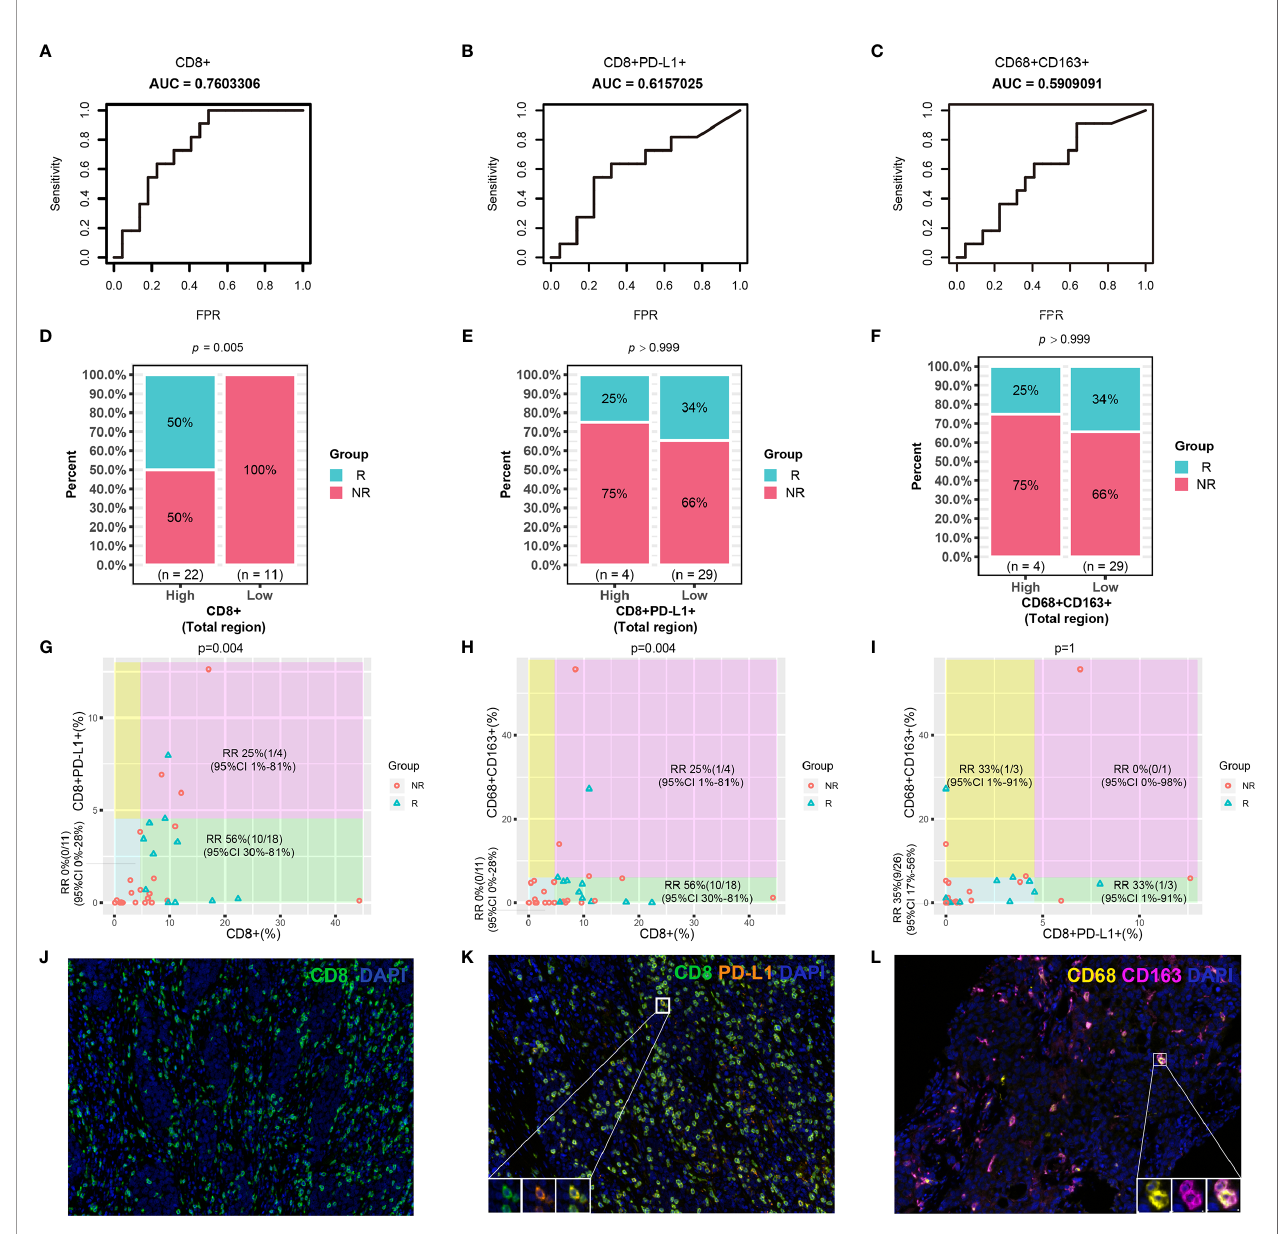
FIGURE 5 | Predictive roles of CD8+, CD8+PD-L1+, CD68+CD163+ and related joint parameters. (A – C) ROC curves for CD8+, CD8+PD-L1+, and CD68+CD163+. (D – F) Chi-square tests for CD8+, CD8+PD-L1+, and CD68+CD163. (G – I) Scatter plot and chi-square test for joint parameters. (J – L) Representative mIHC images of CD8+, CD8+PD-L1+, and CD68+CD163+ cell in fi ltration. NSCLC patients with higher CD8+ and lower CD8+PD-L1+ and CD68+CD163+ cell in fi ltration were more likely to respond to ICI therapy than patients with other cell in fi ltration patterns. RR, response